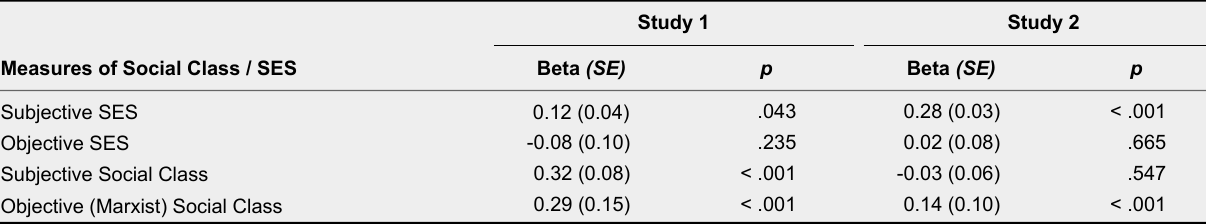
Regression of Composite Work Factors on Measures of Social Class and SES